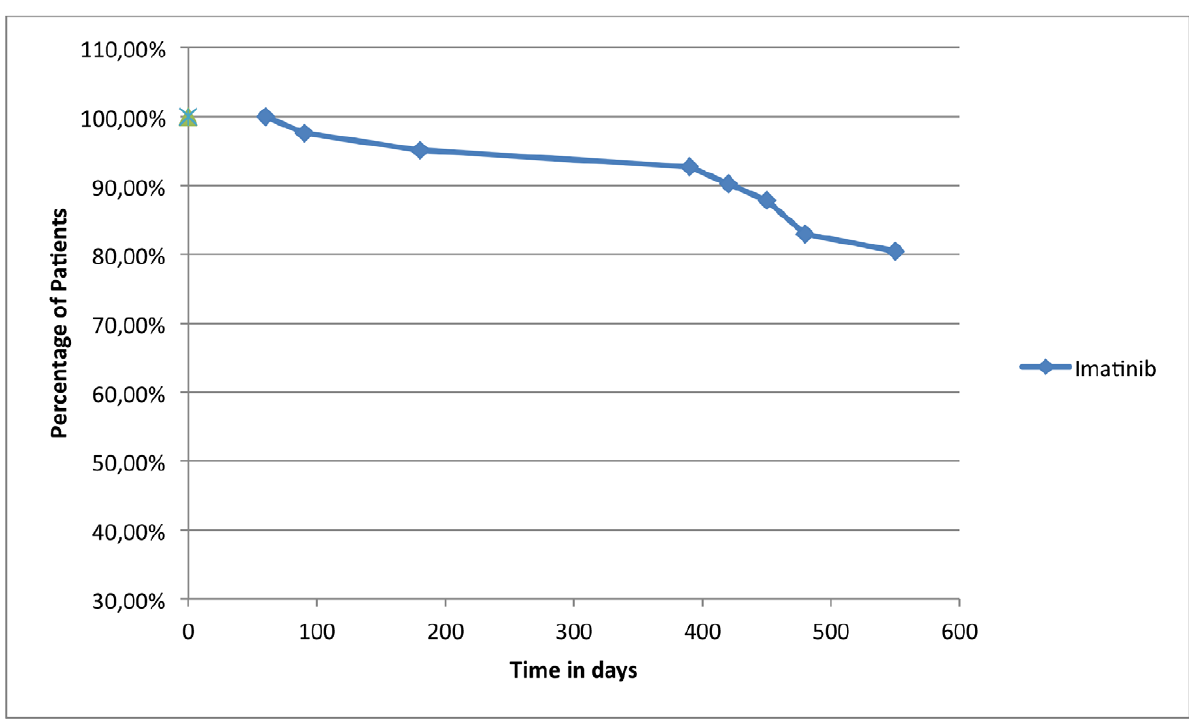
Figure 3. Kaplan Meier Representation of Persistence to 18 months of therapy with Imatinib.